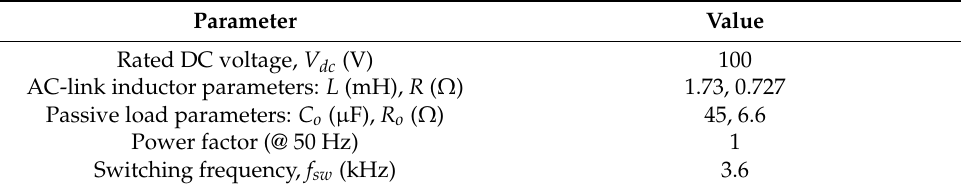
Table 1. Experimental setup circuital